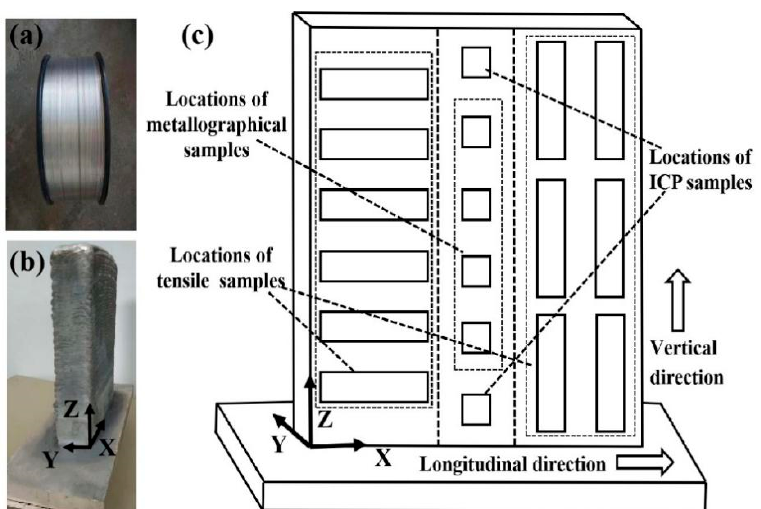
Figure 2. ( a ) The wire used in wire and arc additive manufacturing based on cold metal (WAAM-CMT); ( b ) The samples fabricated by WAAM-CMT; ( c ) Specimens extraction locations and definition of three directions (X, Y, Z).